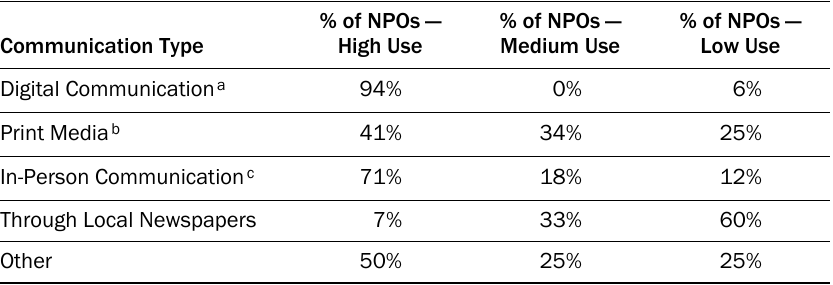
Table 2. Methods of Communication with Constituents Reported by Nonprofit Organizations (NPOs)